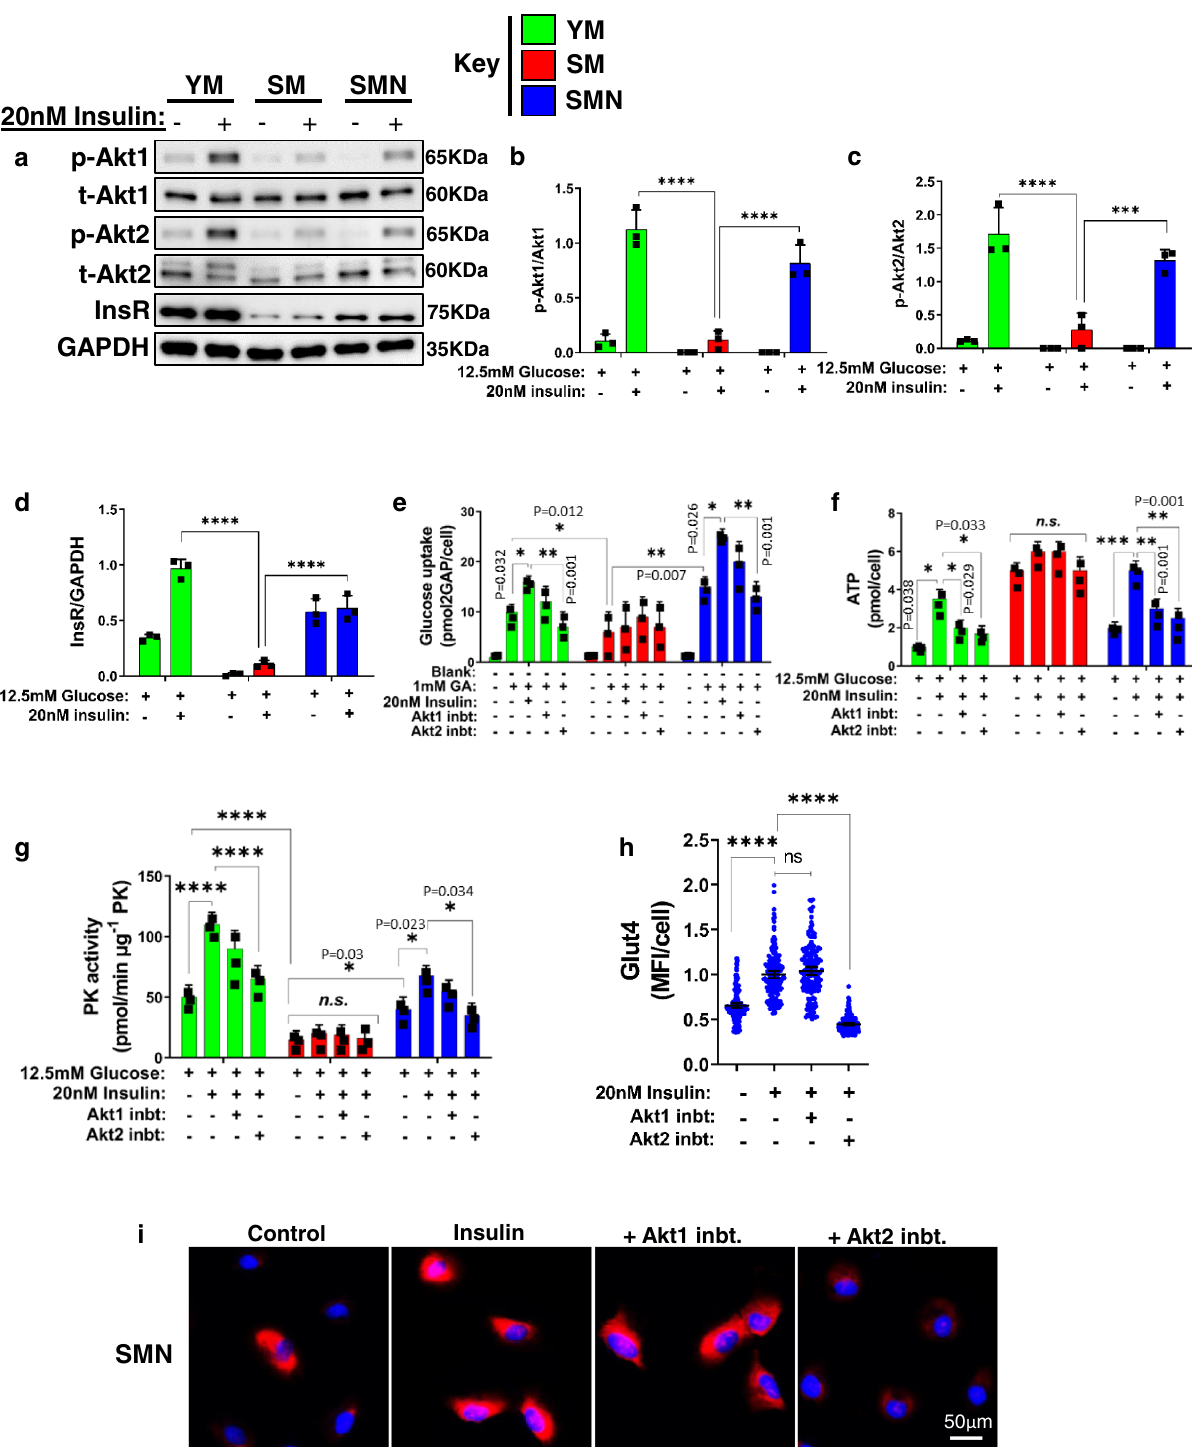
Fig. 2 | NANOG rejuvenated human myoblasts repair insulin resistance. a Western blots for total Akt1, Akt2, insulin receptor, and phosphorylation of Akt1 and Akt2. GAPDH served as a loading control. b , c Quanti fi cation of western blots shown as ratios of p-Akt1 to total Akt1 and p-Akt2 to total Akt2. d Quanti fi cation of western blots for insulin receptor normalized to GAPDH. (*** p =0.0005 and **** p <0.0001) statistical signi fi cance using two-way ANOVA with Tukey ’ s multiple comparisons test. e Glucose uptake by myoblasts supplemented with 1mM of glucose analog (GA), in the presence of 20nM insulin or Akt1 or Akt2 inhibitor. f , g The levels of intracellular ATP ( f ) and pyruvate kinase activity ( g ), upon treat-